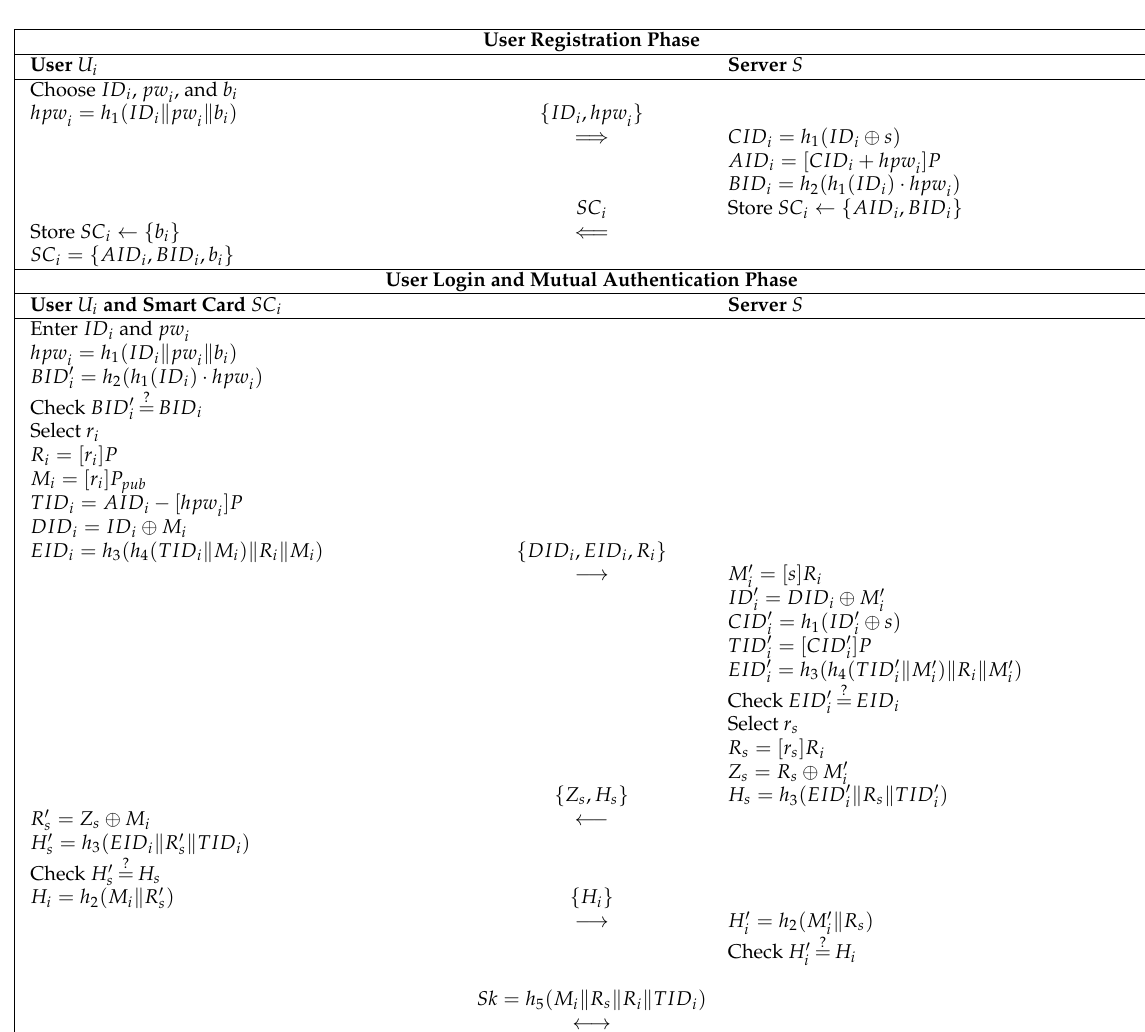
Figure 2. Scheme by Chaudhry et al. [32] based on